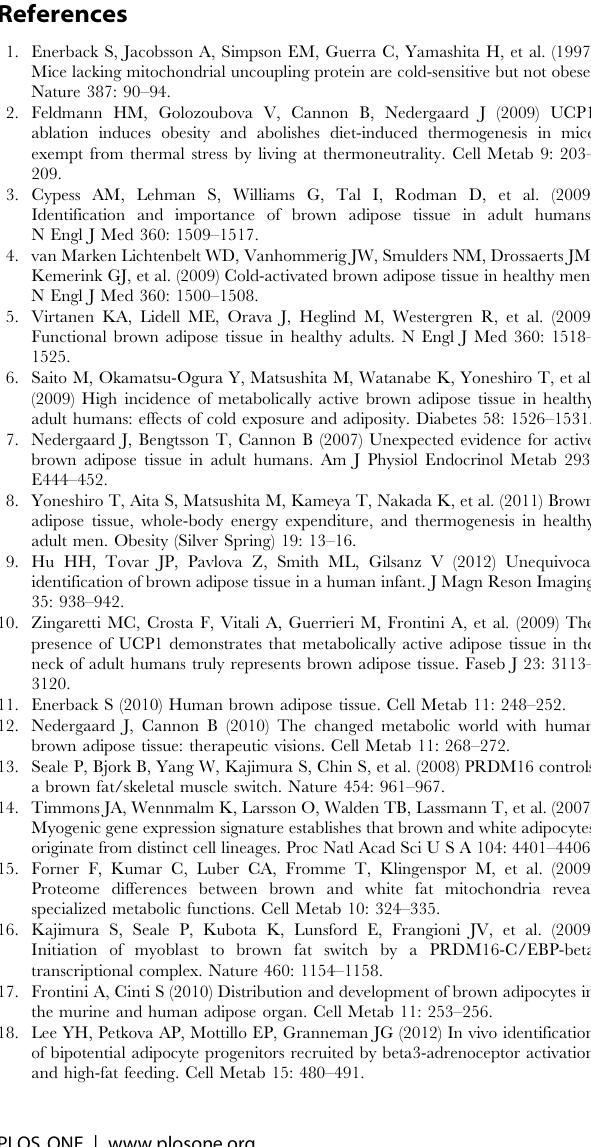
Table S2 Patient and sample information for the tissues used in the expression analyses. (PDF) Table S3 Genes enriched in rosiglitazone-inducible beige/brite cells. (PDF) Table S4 Genes enriched in classical brown adipocytes (PDF)